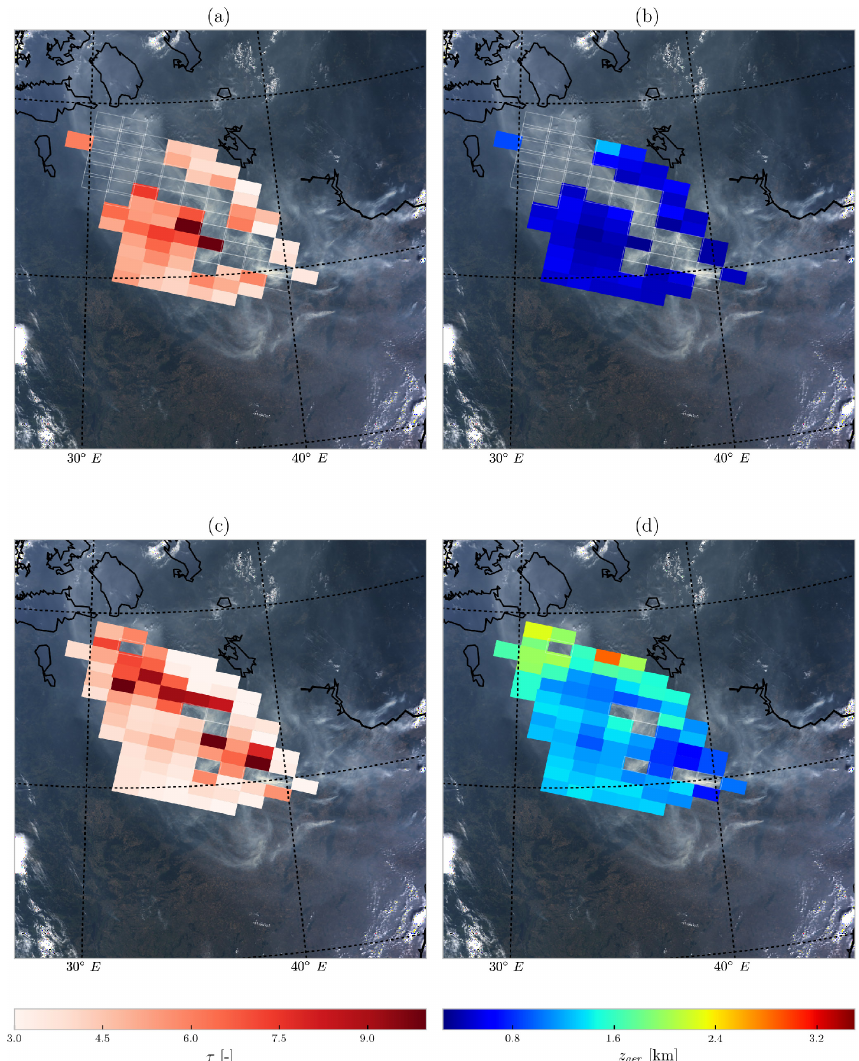
Figure 4. Results from processing 85 GOME-2A pixels over Russia on 8 August 2010 using the formal approach and the dynamic scaling method. Empty GOME-2A pixels with a white border represent non-convergences. (a) Fitted τ at 760nm from the formal approach. (b) Re- trieved z aer from the formal approach. (c) Fitted τ at 760nm from the dynamic scaling method. (d) Retrieved z aer from the dynamic scaling method. The background image for all plots is a subset of the MODIS Terra image in Fig.